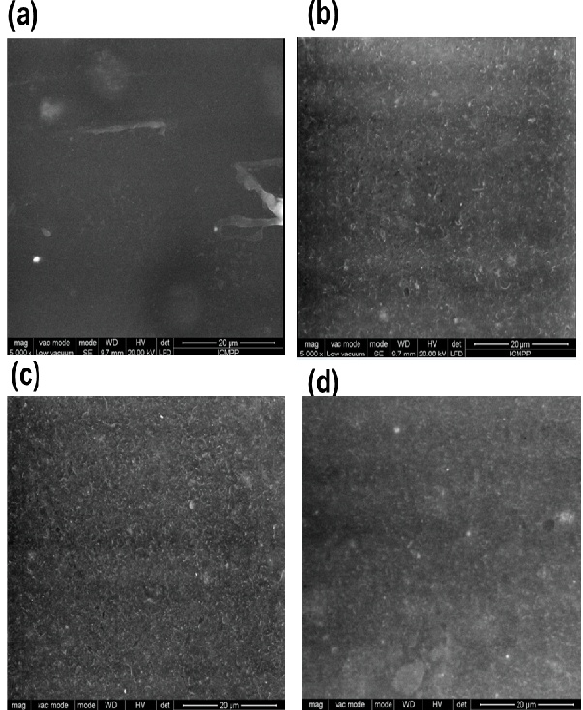
Figure 7. Scanning electron microscopy (SEM) image ofPVA/mMWCNTs composite system nanocom- posites containing different filler amount of mMWCNTs: ( a ) 0.5 wt%, ( b ) 1 wt%, ( c ) 2.5 wt%, and ( d ) 5 wt%.